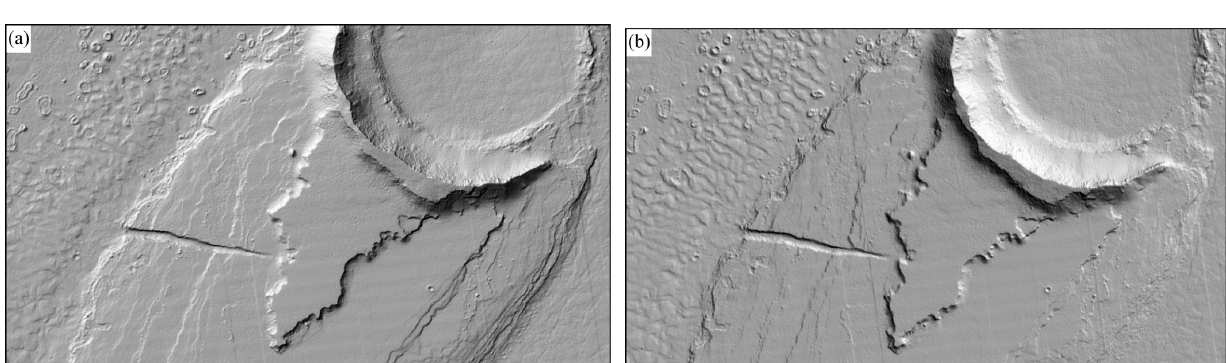
Figure 1. Angle dependence of analytical hill-shading: 315° azimuth illumination (a) , and 45° azimuth (b) . Note the lower right corner of both plates where the relief structures have a main direction of about 45°. Almost no relief details can be observed in (b) because the structures lie in the direction of shading. The image shows ring and cone structures, and dunes in Athabasca Valles, Mars (data from HiRISE instrument aboard Mars Reconnaissance Orbiter [1]; credits to NASA/JPL/University of